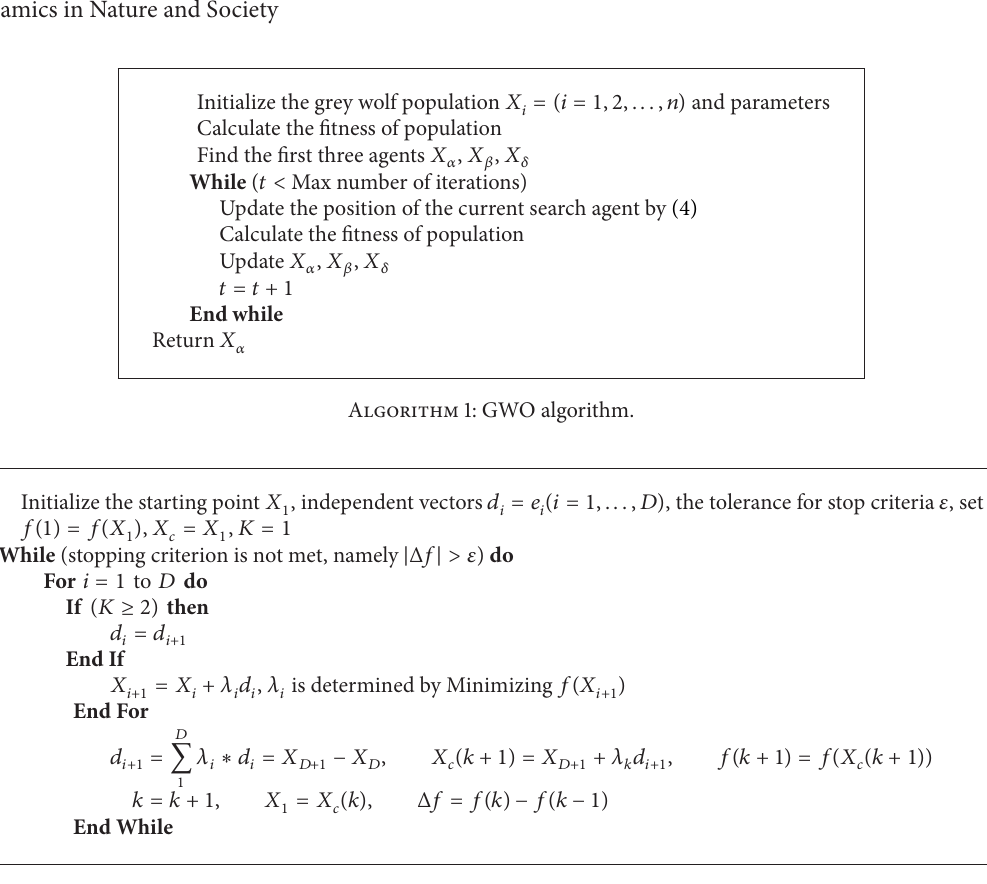
Algorithm 2: Powell’s